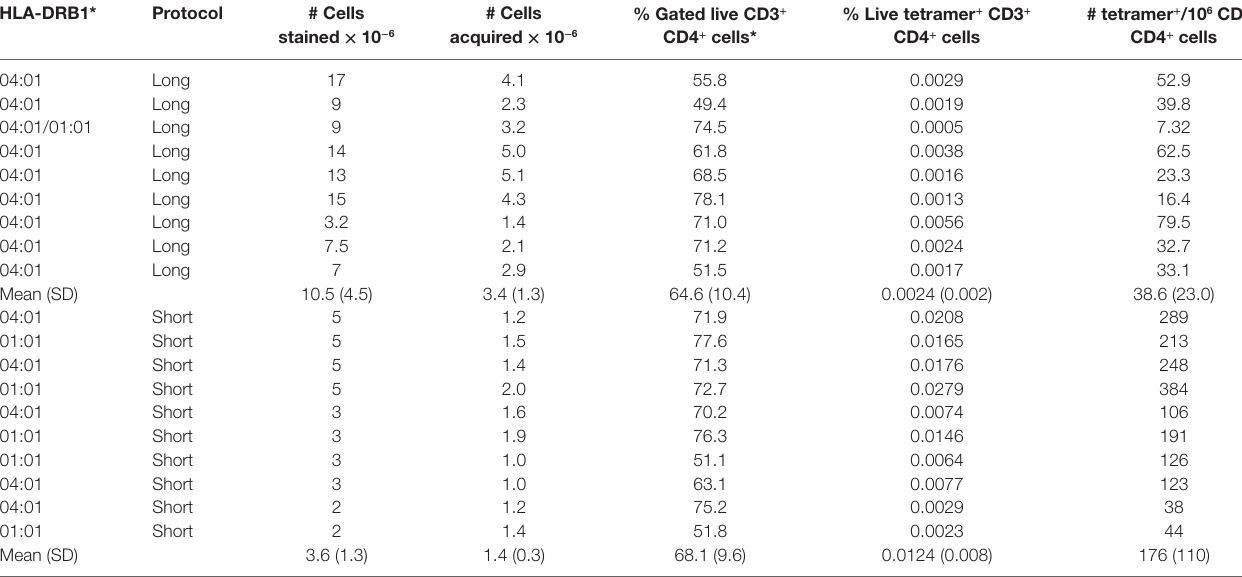
tAbLe 3 | Identification of tetramer + cells after short and long staining protocols. hLA-dRb1*